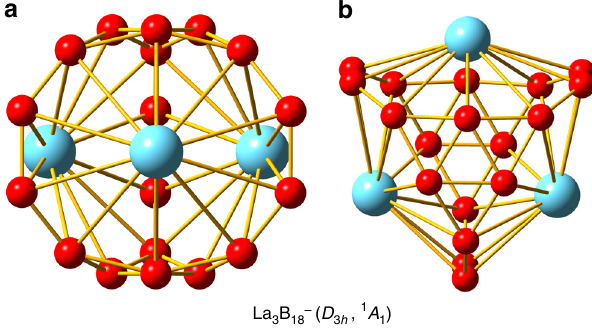
Fig. 3 The global minimum structure of La 3 B 18 – ( D 3 h , 1 A 1 ) at the PBE0/ TZP level. a The C 3 axis is along the page vertically. b The C 3 axis is perpendicular to